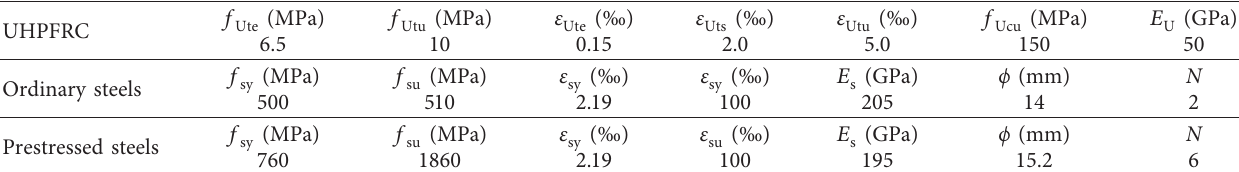
Table 2: Material characteristic